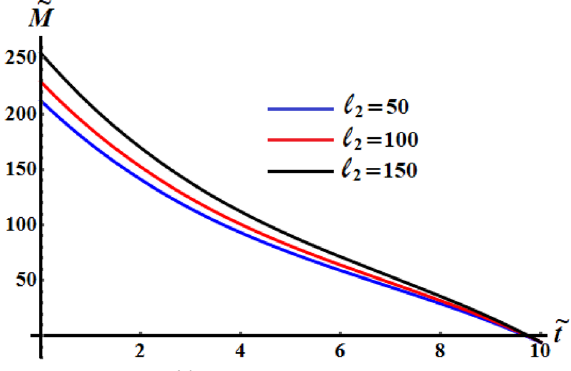
Figure 9. Exhibits the solutions ˜ M ( ˜ t ) when ℓ 1 = 200 kg m 2 s − 1 and ℓ 3 = 50 kg m 2 s − 1 at ℓ 2 ( = 50, 100, 150 ) kg m 2 s − 1